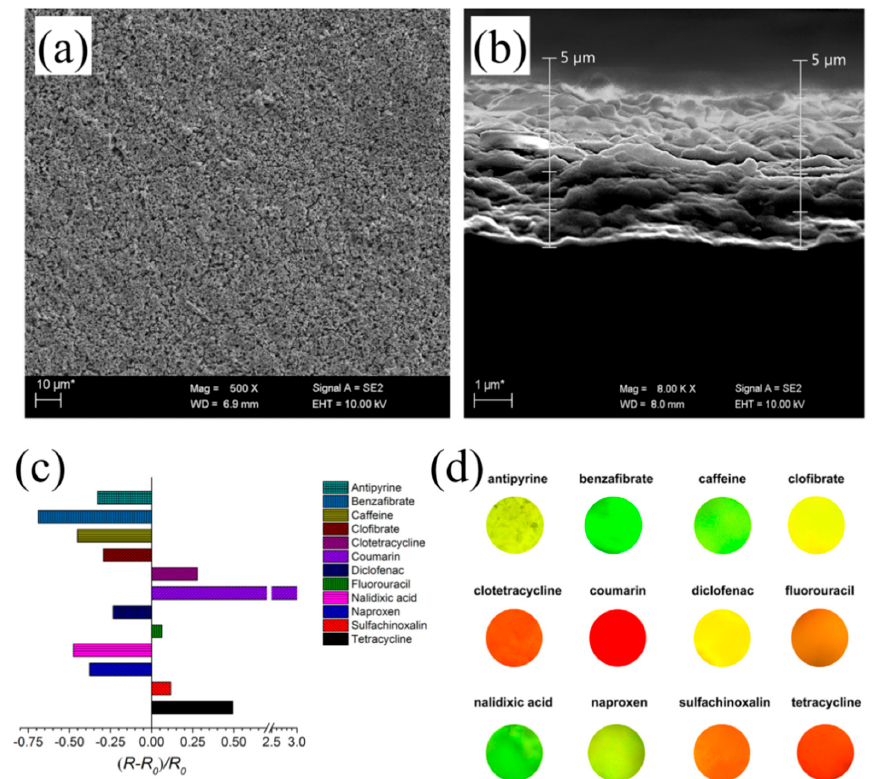
Figure 23. SEM images of ( a ) the surface and ( b ) the cross section of Eu 0.1 Tb 0.9 -BTC film; The emission intensity ratio changes ( c ) and the optical photographs (d) of Eu 0.1 Tb 0.9 -BTC thin film in the presence of different analytes (20 mL, 10 − 4 M). Reprinted with permission from Reference [92]. Copyright 2018 Elsevier.